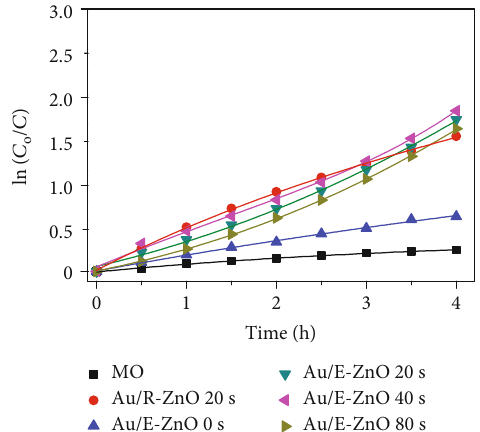
Figure 16: Plot of ln ð C / C Þ versus irradiation time of MO 0 degradation, Au/R-ZnO 20 s, pristine Au/E-ZnO, and Au/E-ZnO nanocomplex with di ff erent Au content (20 s, 40s, and 80s) irradiated with UV light,